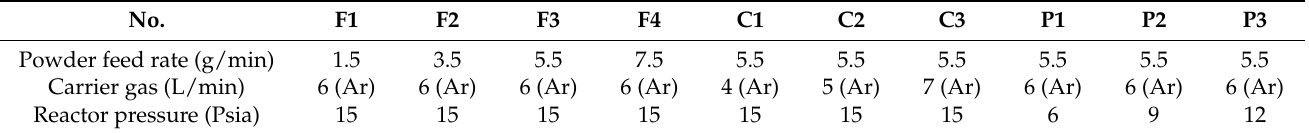
Table 1. The parameters of RF induction plasma in the experiment.